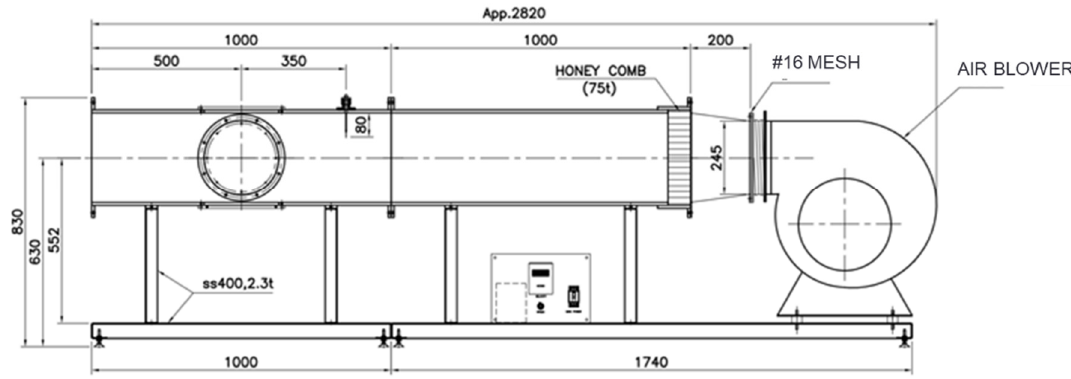
Figure 6. Schematic of small wind tunnel.